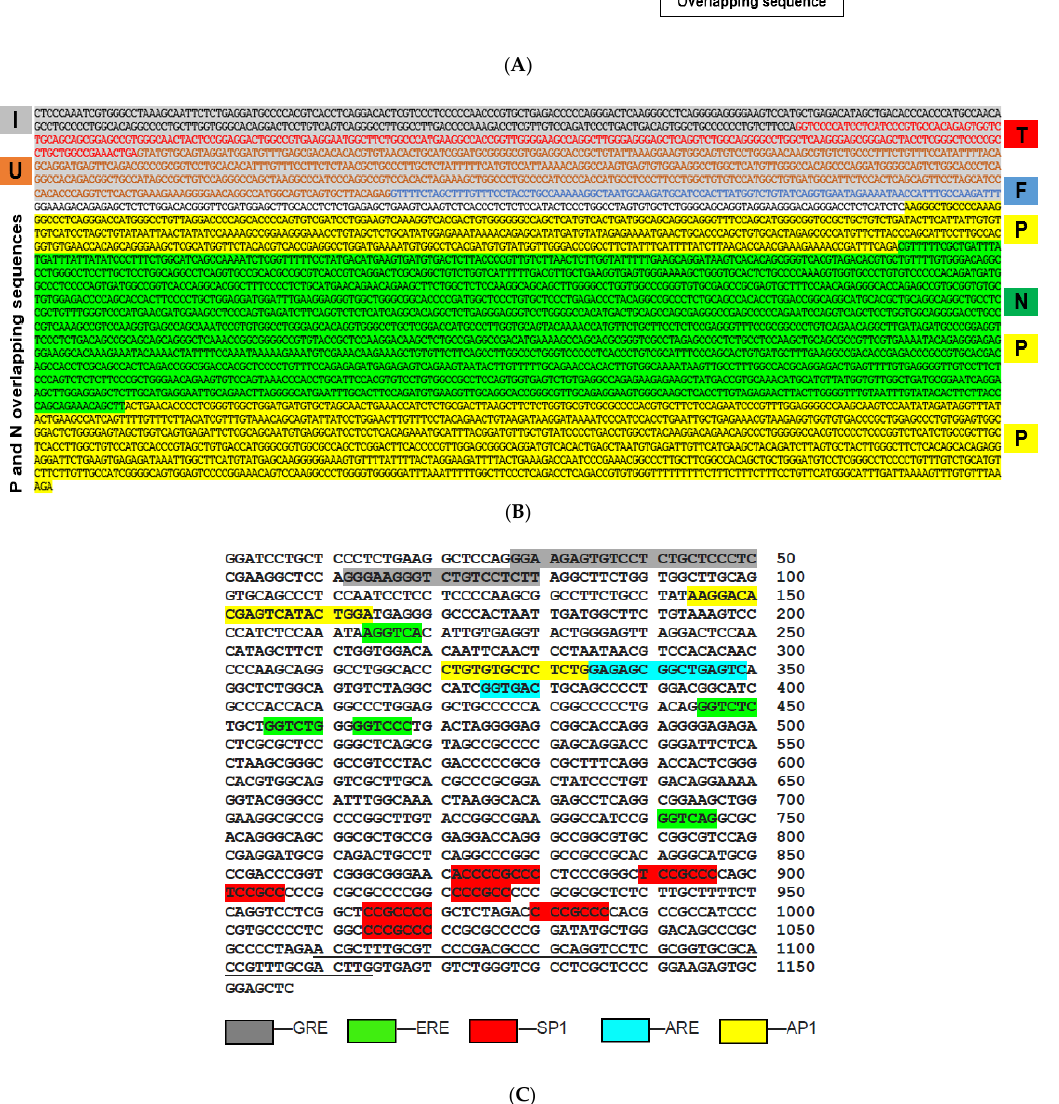
Figure 2. ( A )—Schematic representation of the MGMT mRNA transcript, MGMT 5’-UTR, coding sequence, 3’-UTR region, and the added 3 kb sequence in the updated version of the GenBank-Gene that hosts the overlapping sequences of a discontinued protein-coding locus 105378559 transcript XM_011540451.1, and an ncRNA transcript, ENSG00000227374. ( B )—The sequence of 3’-side of the MGMT locus showing the 3 kb of the two overlapping genes, uncharacterized locus 105378559 protein-coding (P) and RP11-109A6.3/ENSG00000227374 ncRNA gene (N). Letters I, T, U, and F respectively refer to the end of MGMT intron-4, the translated region of exon-5, the untranslated region of exon-5, and MGMT genomic feature respectively. The short non-highlighted sequence relates to the genomic region between the MGMT locus and the sequence of overlapping genes. ( C )—Distribution of motifs in the established MGMT promoter X61657.1 mapped to chr10: 129466183 -129467339 [23]. The promoter was screened manually to locate the color-coded consensus recognition motifs. This is the first report describing ARE and ERE in the promoter. Note that the end of the AP1 recognition sequence overlaps with the ARE. The underlined sequence represents the untranslated MGMT exon 1.